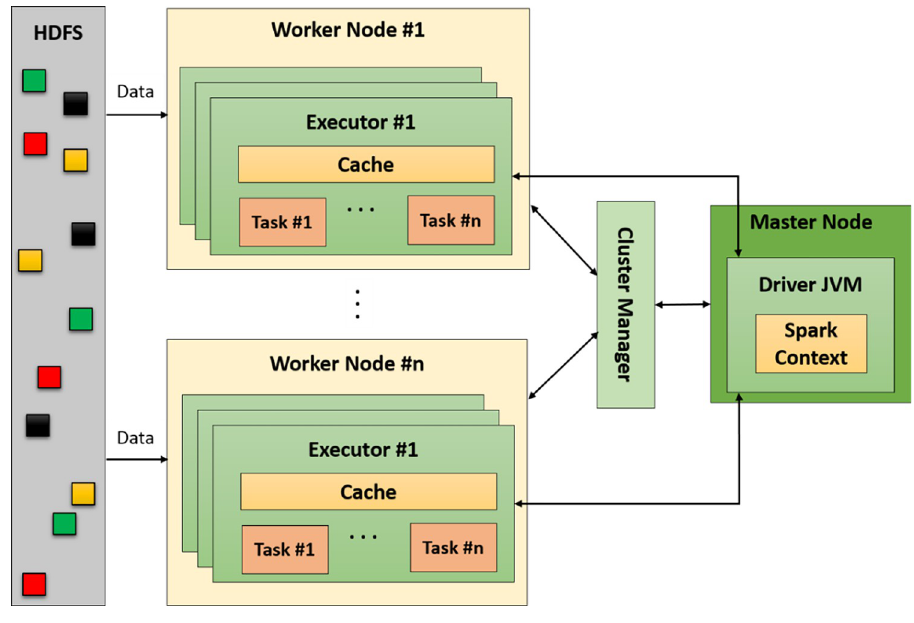
Fig 2. Spark cluster architecture